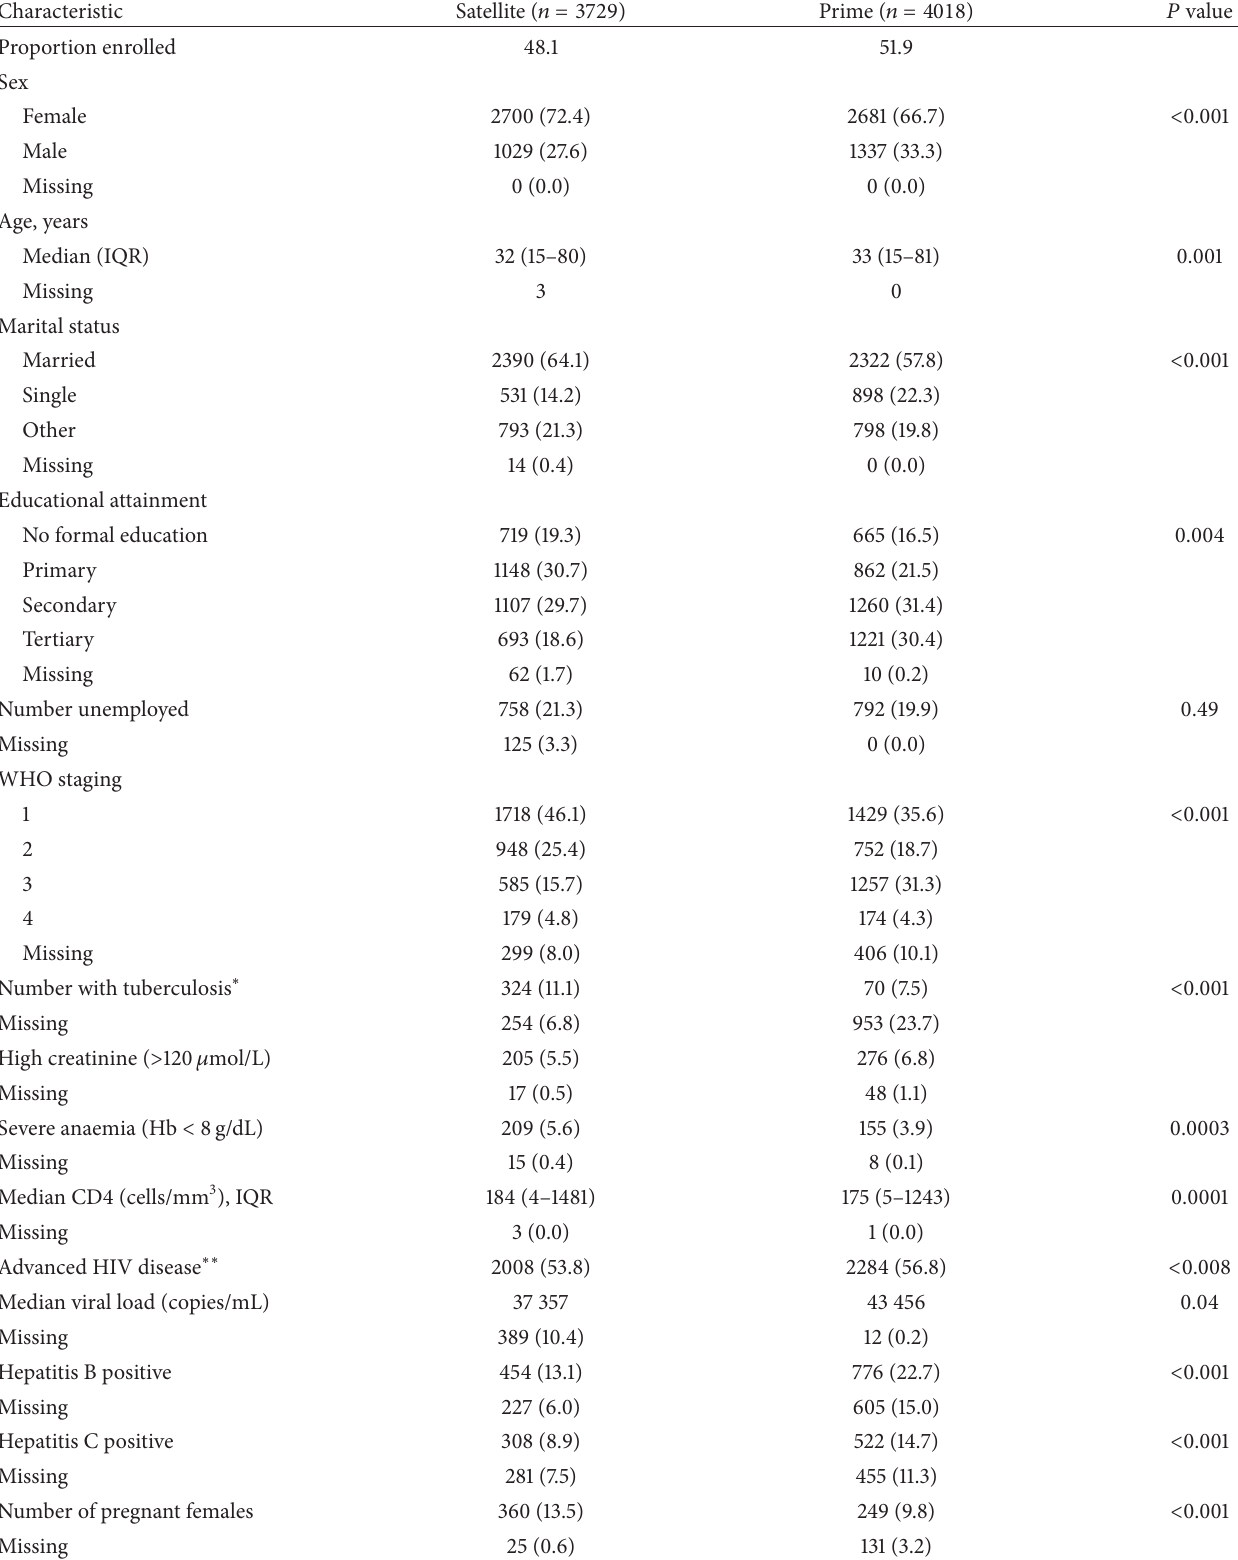
Table 2: Comparison of baseline characteristics between patients enrolled at the prime and satellite sites in the decentralized ART program in Jos,